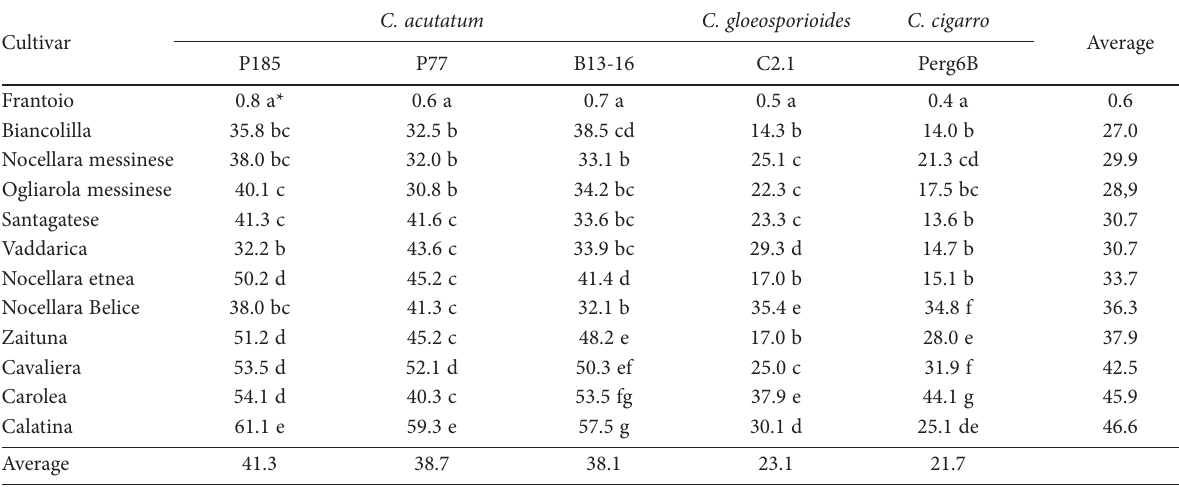
Table 2. Mean Area Under Disease Progress Curves (AUDPCs) for 11 traditional Sicilian olive cultivars and ‘Frantoio’ (used as resistant control) inoculated with three isolates of C olletotrichum acutatum (P185, P77 or B13-16) , or one isolate each of C. gloeosporioides (C2.1) , or C. cigarro (Perg6B) .